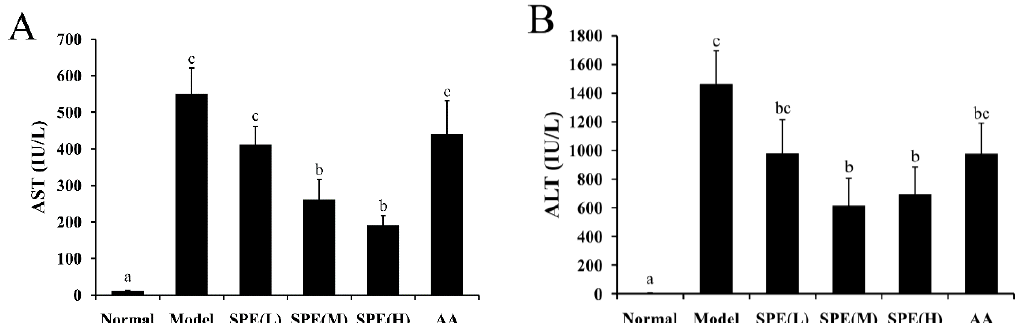
Figure 2. The effects of sheep placental extract (SPE) on serum biochemical markers 8 h after injection of Con A. The activities of alanine transaminase (AST) and aspartate transaminase (ALT) are presented in A and B , respectively. Values are represented as means ± SE ( n = 11). a, b, c and bc in the figures show statistically significant differences ( p < 0.05) among groups. The experimental groups pretreated with low dose SPE (5 mg/kg), medium dose SPE (10 mg/kg), high dose SPE (50 mg/kg) or the mixture of 18 amino acids equal to 50 mg/kg SPE group are labelled as SPE (L), SPE (M), SPE (H) and AA, respectively.